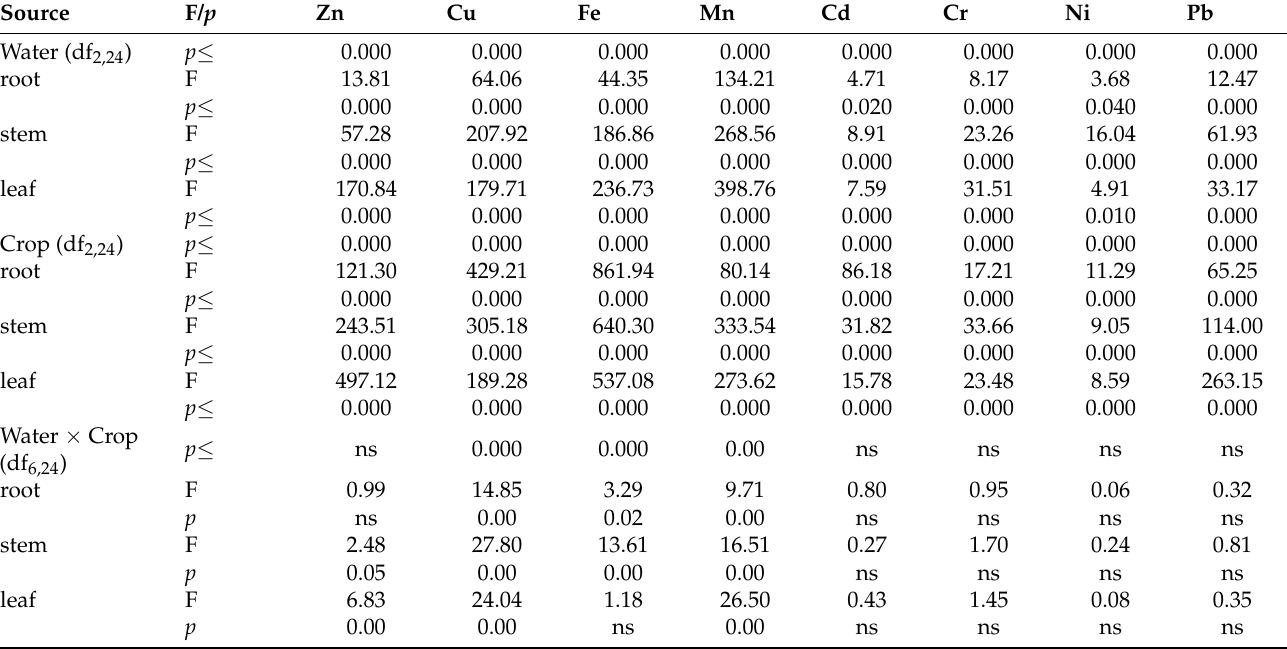
Table 2. Results of a two-way MANOVA for phytoextraction of heavy metals by root, stem, and leaf of study crops ( B. juncea , E. sativa , B. rapa, and B. napus ) irrigated with canal water, wastewater, and canal + wastewater (1:1; v / v ) in Multan.